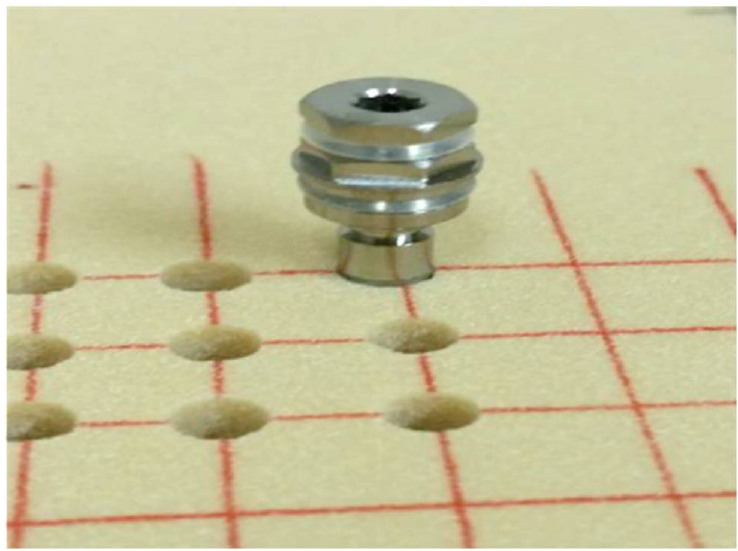
Figure 2. Acceptance criteria: insertion torque ≥50 N/cm; full insertion flush with the bone model surface.